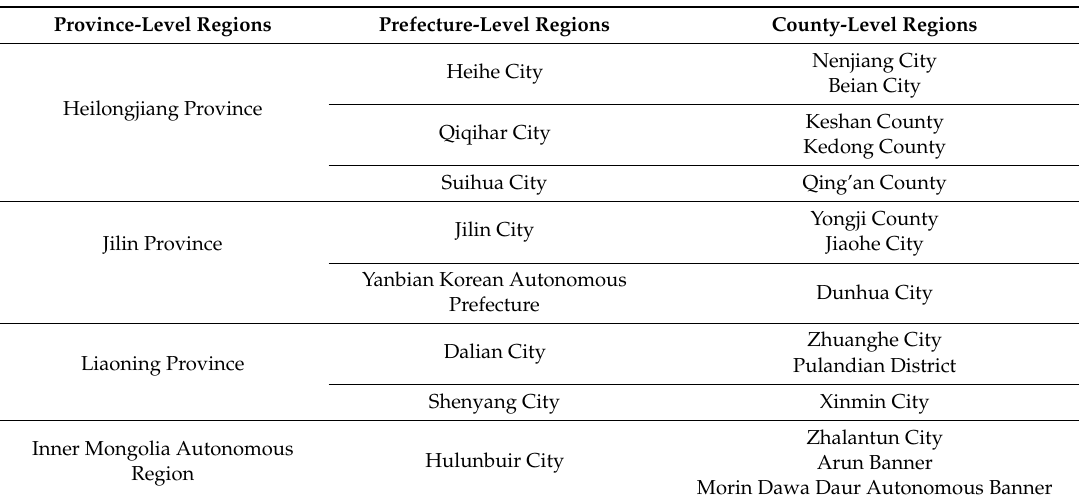
Table 2. Distribution of survey